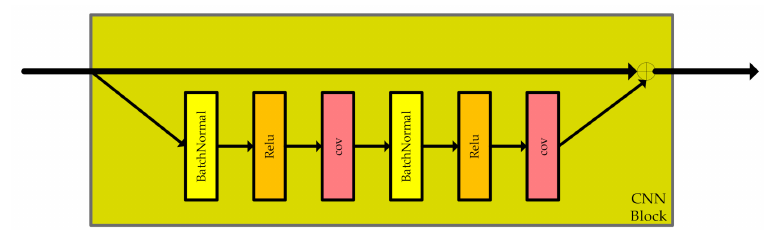
Figure 5. The structure of CNN